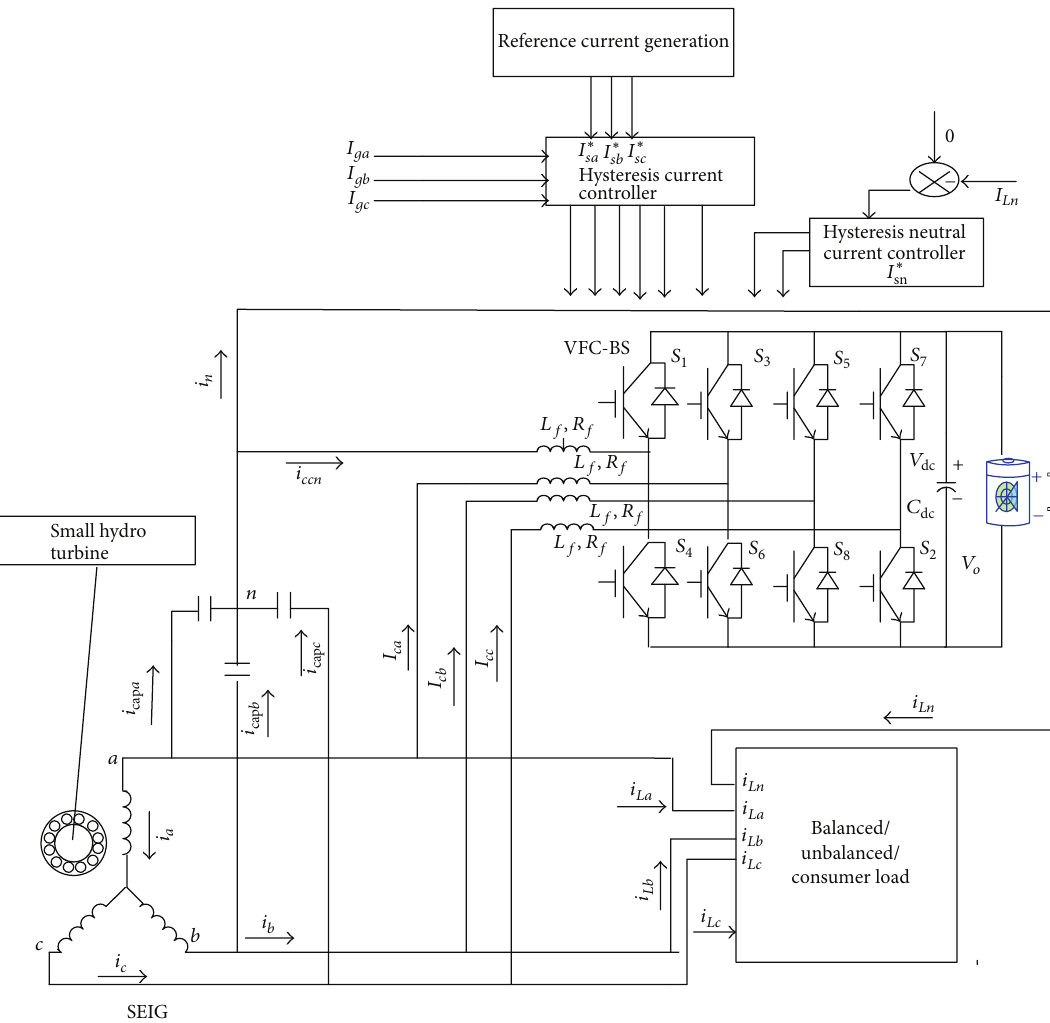
Figure 2: The illustrative diagram of plant “1” with its entire control unit.